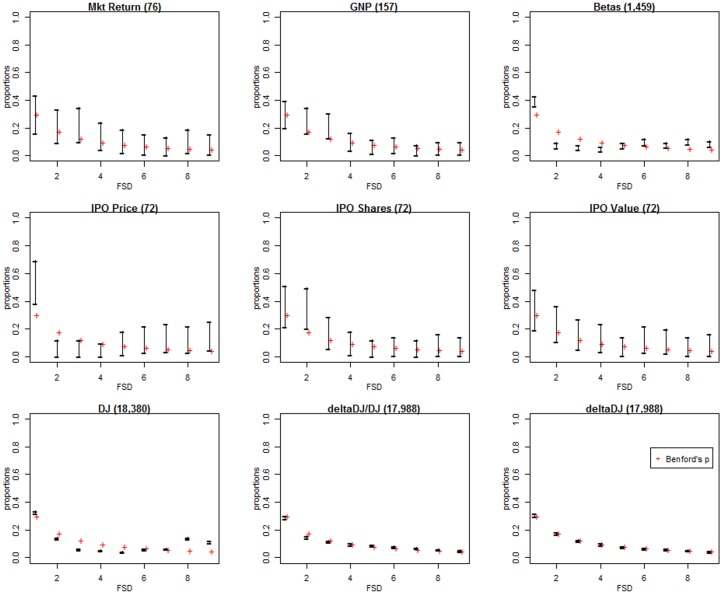
Goodman simultaneous confidence intervals for the Rodriguez data.Vertical line segments denote the Goodman simultaneous confidence intervals computed from the Rodriguez data. The red crosses are positioned at the Benford probabilities. The sample size for each data set is given in brackets in the heading.